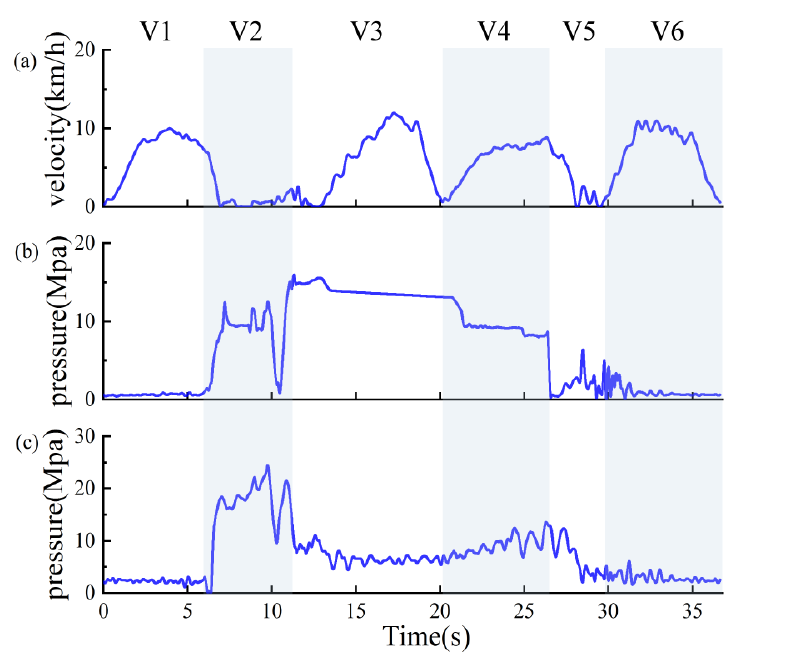
Figure 6. Schematic diagram of working condition division: ( a ) velocity of wheel loader; ( b ) lift cylinder pressure; ( c ) tilt cylinder